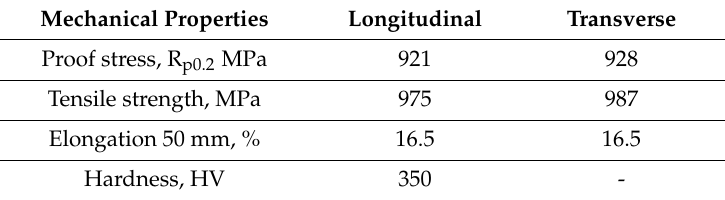
Table 5. Mechanical properties of the reference (Ref)